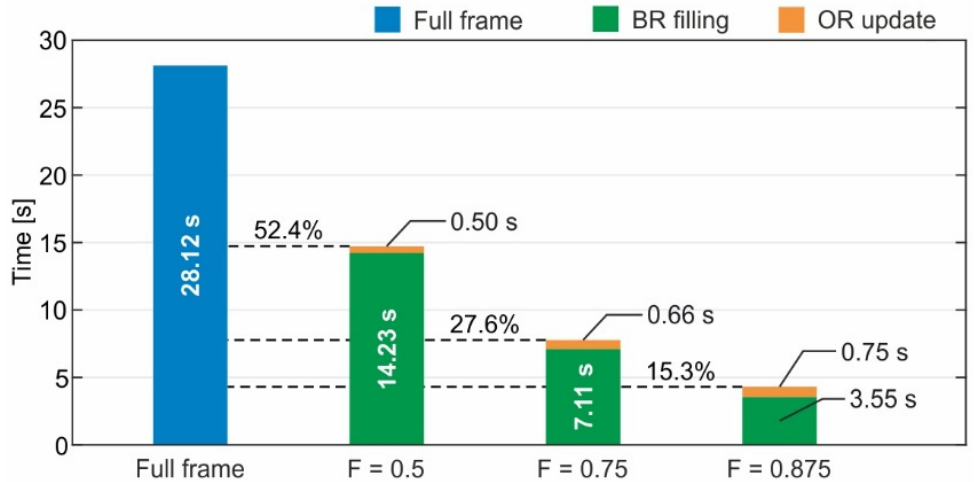
Figure 7. Comparison of computation time of CGH made with A-PAS and update algorithm. The partial times for filling the blank region and updating the overlap region are marked with green for BR filling and orange for OR updating, respectively.